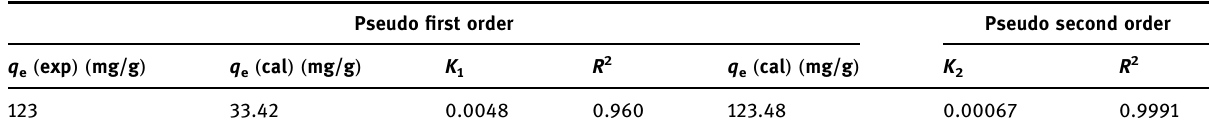
Table 1: The kinetic parameters of pseudo - fi rst - order and pseudo - second - order models for the removal of Cr ( VI ) on the surface of PDA/NC nanocomposite